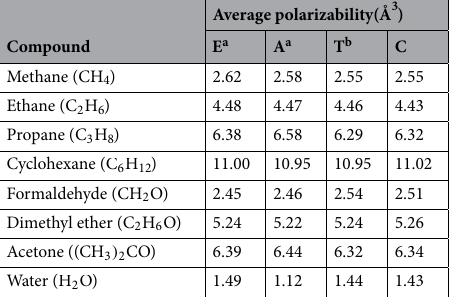
Table 2. Experimental versus calculated polarizabilities for various small molecules: Experimental (E), Applequist et al. (A), Thole (T), Calculated (C). (cid:31) = 589.3 nm. Values from Ref. 36 Values from Ref. 28 .